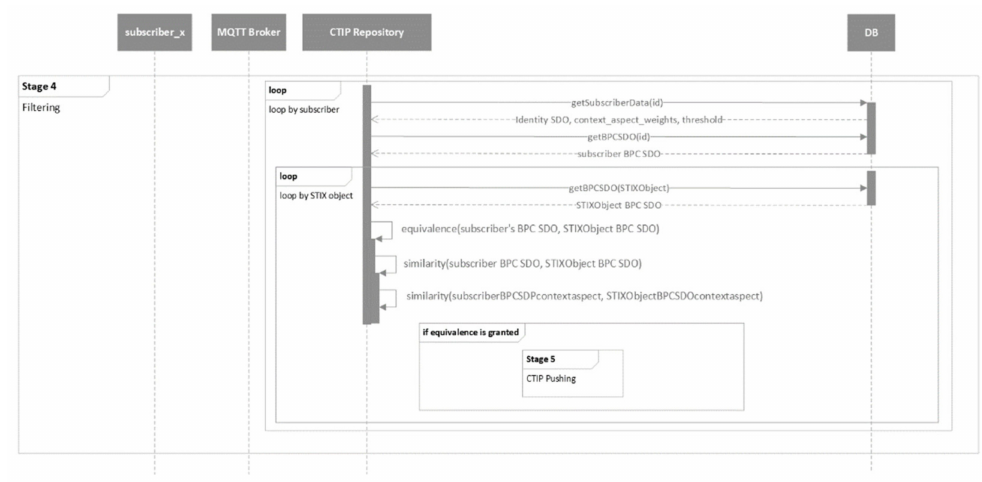
Figure 13. UML behavioral diagram of the filtering stage (stage 4).